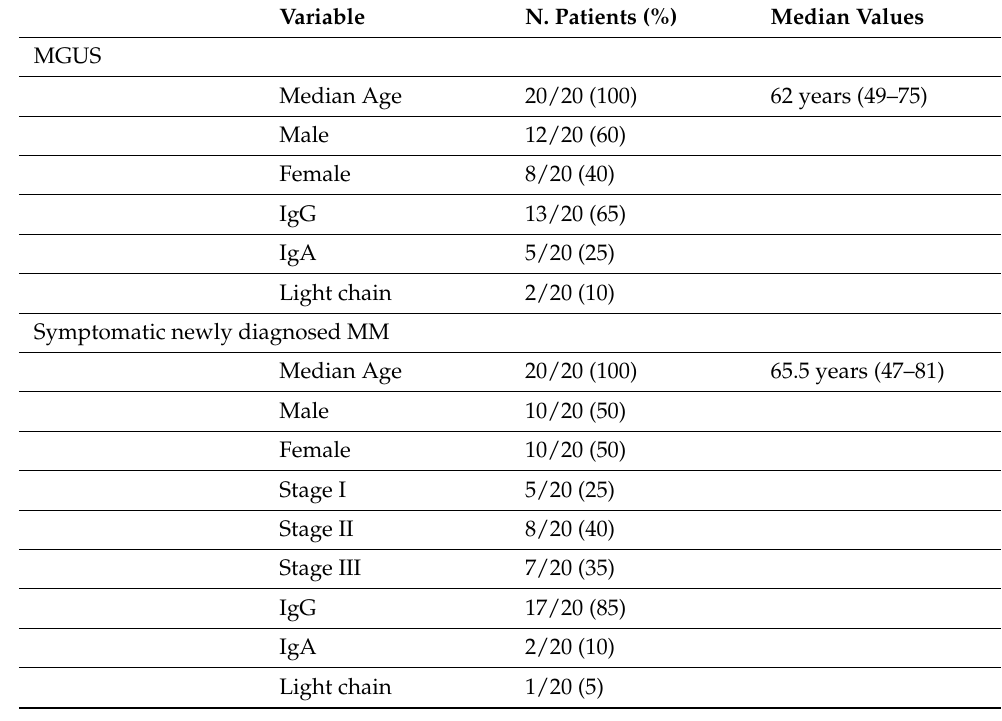
Table 1. Clinical characteristics of the